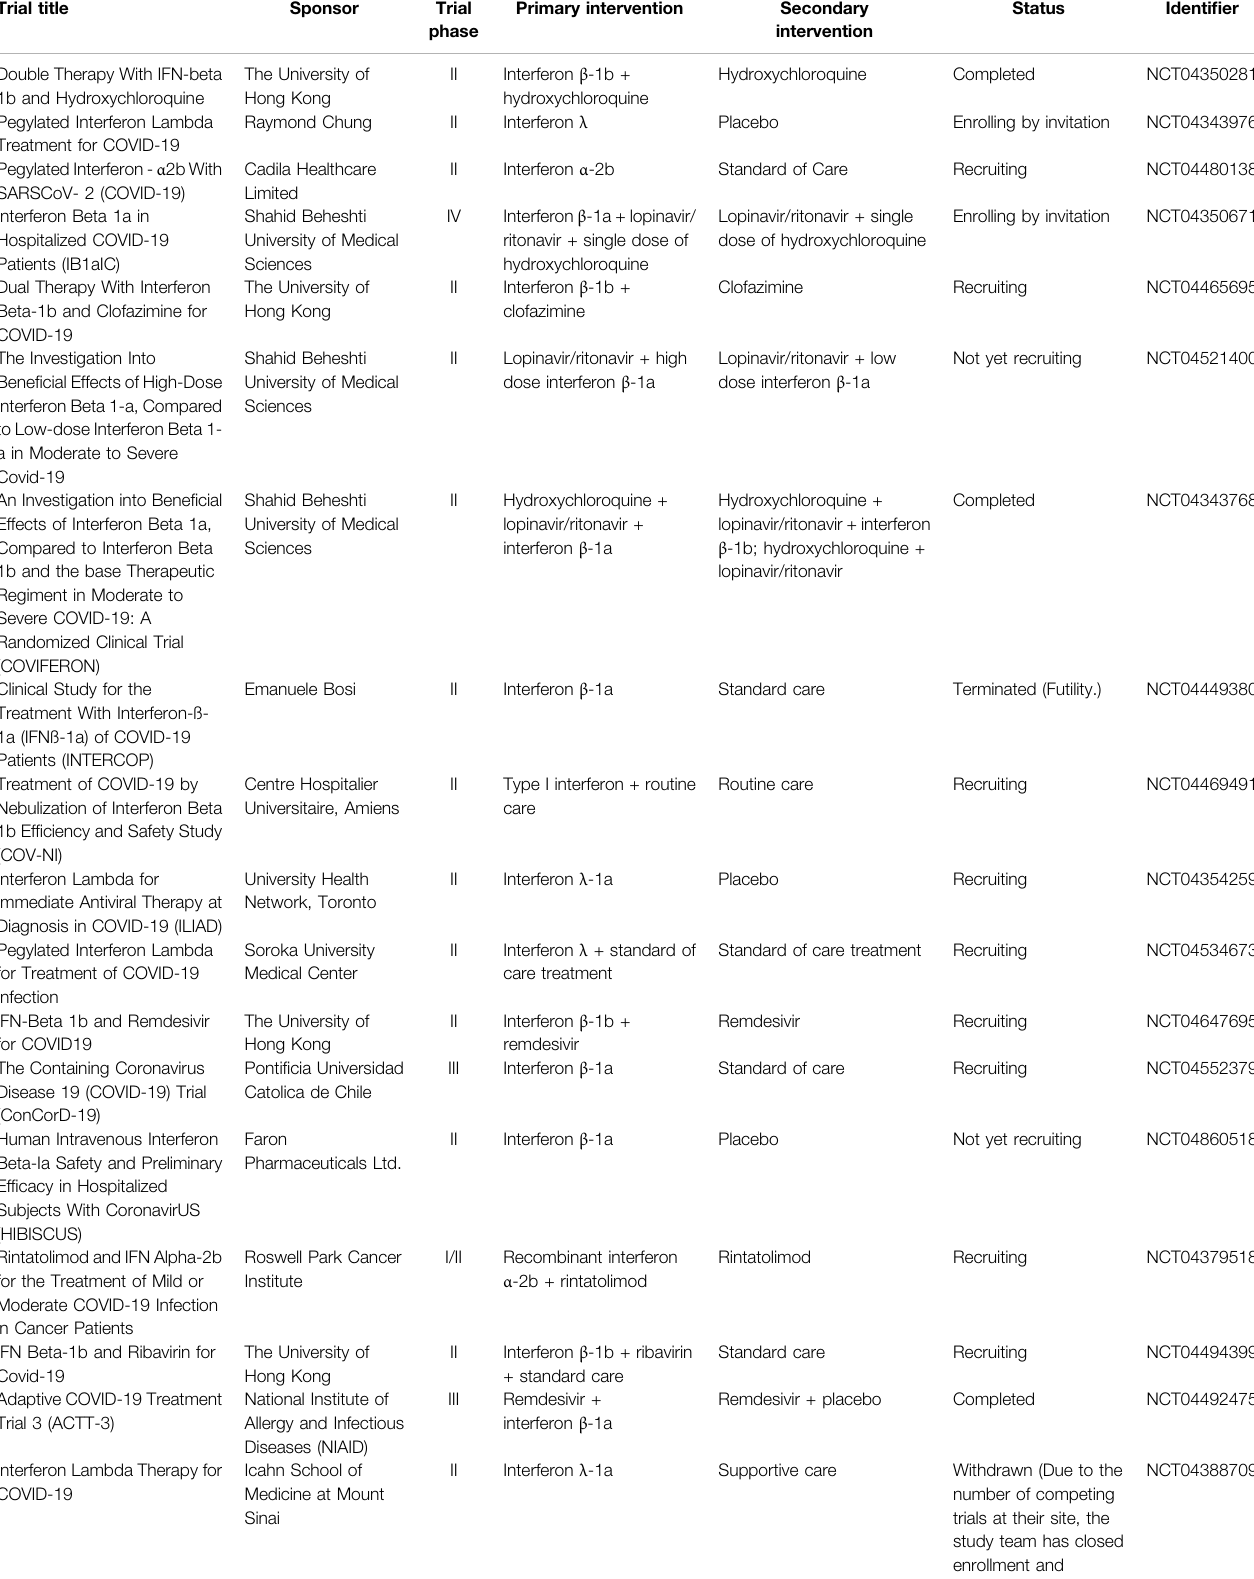
TABLE 4 | Summary of clinical trials of interferons (IFNs) on COVID-19